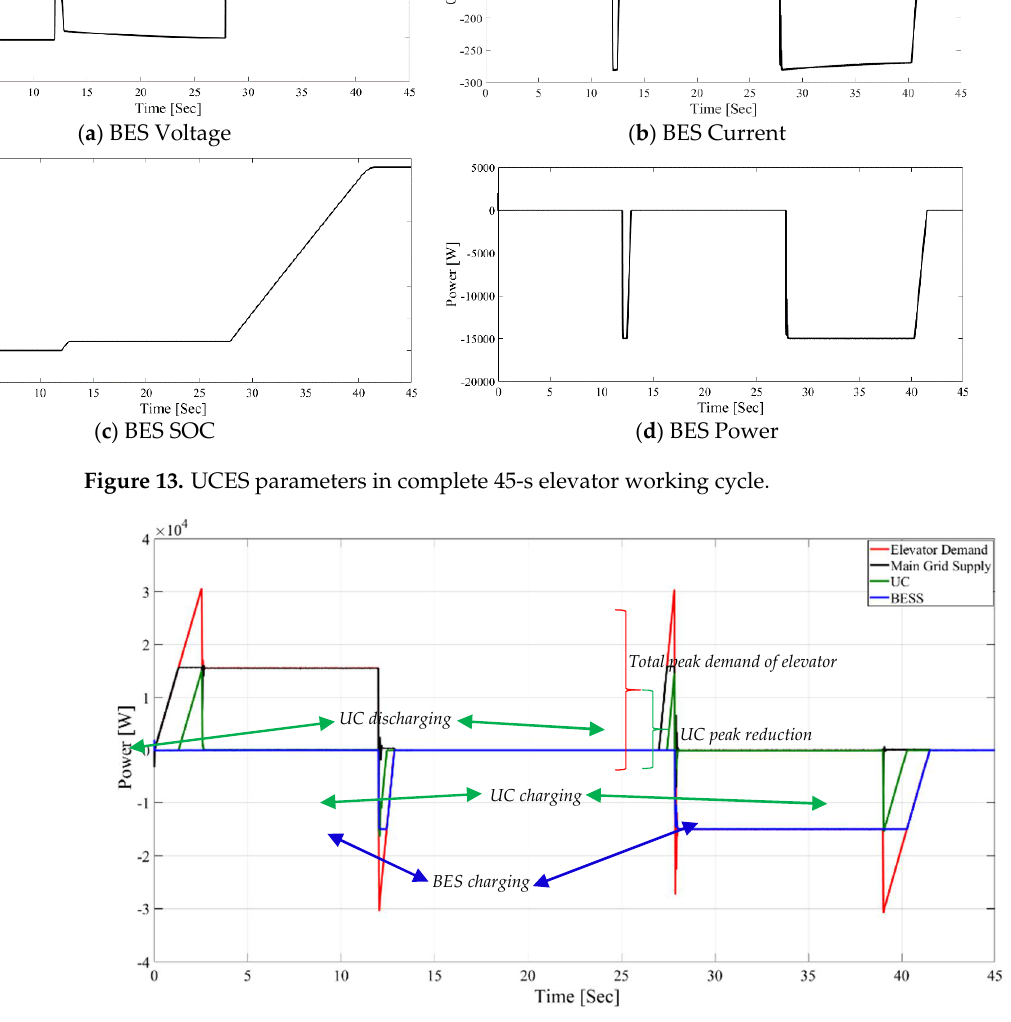
Figure 14. Elevator power supply provided by UCES, BES, and the main grid.